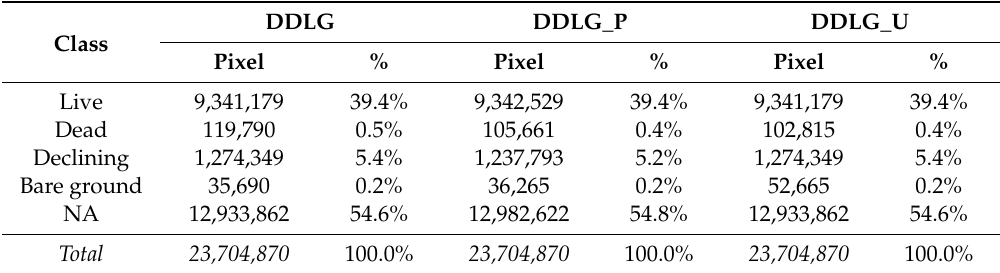
Table 6. Classification results per class in number and percent (%) of pixels (0.5 × 0.5 m) for the three classification scenarios: Random forest (RF) classification (DDLG), RF classification with